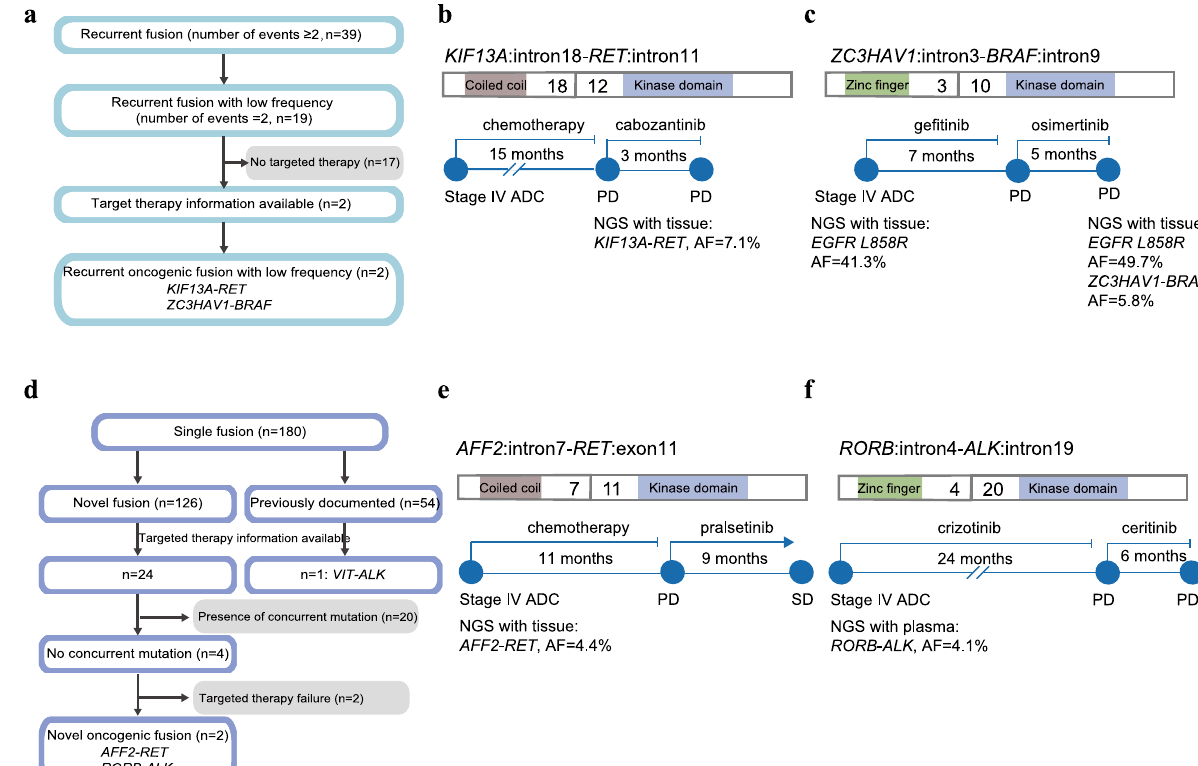
Fig. 5 Potentially druggable fusions in lung cancer patients. a Pipeline of oncogenic fusions among all recurrent fusions. b The structure of KIF13A-RET and clinical information of the patient harboring that fusion. The domains are highlighted in different colors as: coil-coiled domain of KIF13A (brown) and RET tyrosine kinase domain (blue). c The structure of ZC3HAV1-BRAF and clinical information of the patient harboring that fusion. The domains are highlighted in different colors as: zinc fi nger domain of ZC3HAV1 (green) and BRAF tyrosine kinase domain (blue). d Pipeline of novel oncogenic fusions among single fusions. e The structure of AFF2-RET and clinical information of the patient harboring that fusion. The domains are highlighted in different colors as: coil-coiled domain of AFF2 (brown) and RET tyrosine kinase domain (blue). f The structure of RORB-ALK and clinical information of the patient harboring that fusion. The domains are highlighted in different colors as: zinc fi nger domain of RORB (green) and ALK tyrosine kinase domain